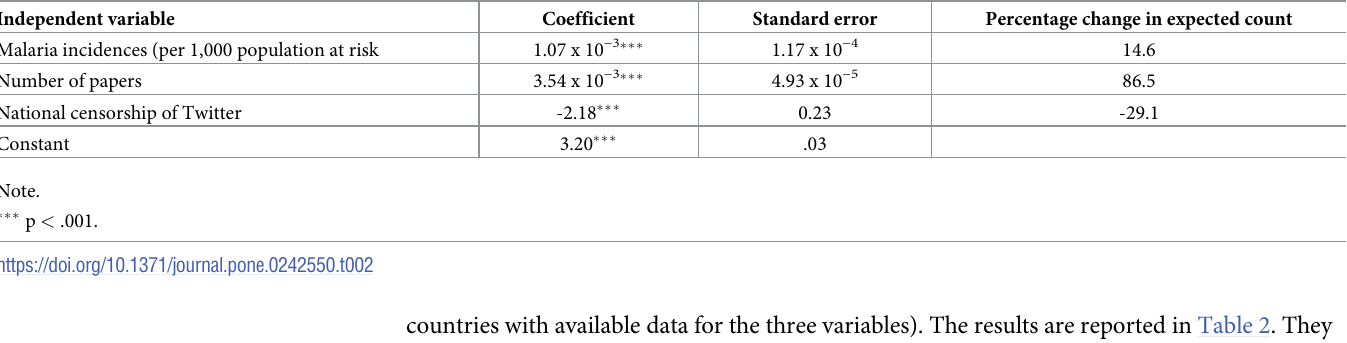
Table 2. Coefficients of a Poisson regression model with number of tweets as dependent variable (n = 79 countries).